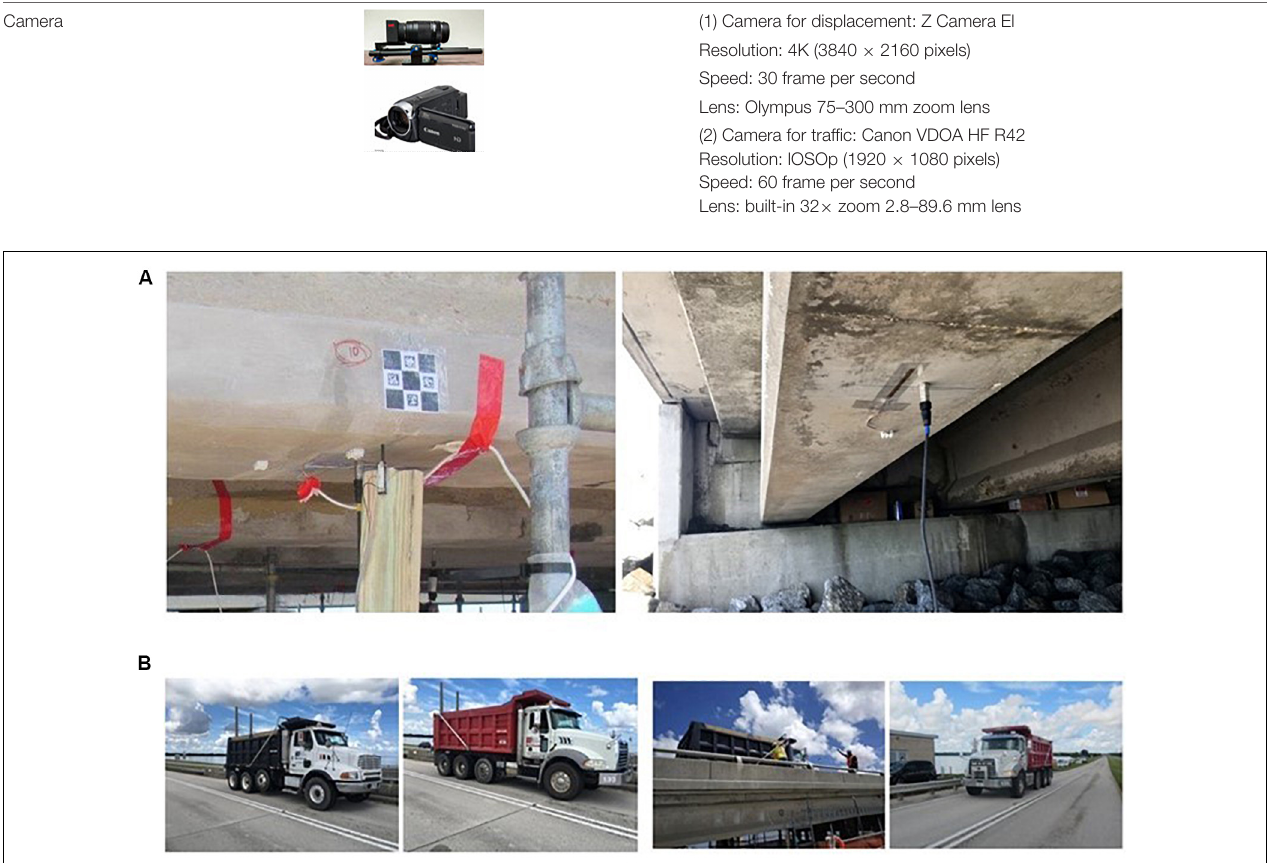
FIGURE 2 | (A) Sensors installed on the bottom of the girders (B) Loading